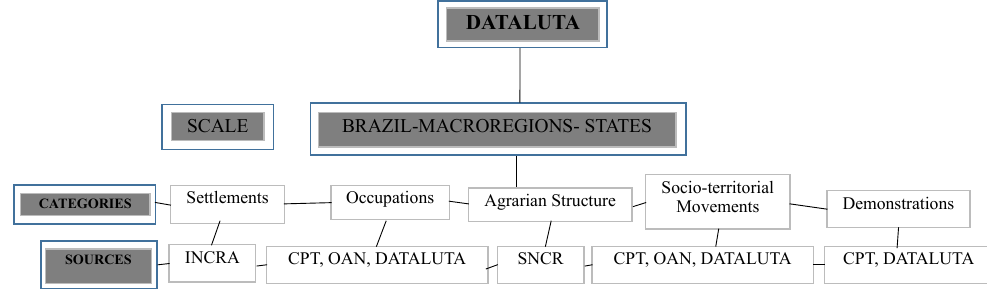
Figure 1. DATALUTA scales and categories. Source: [27],